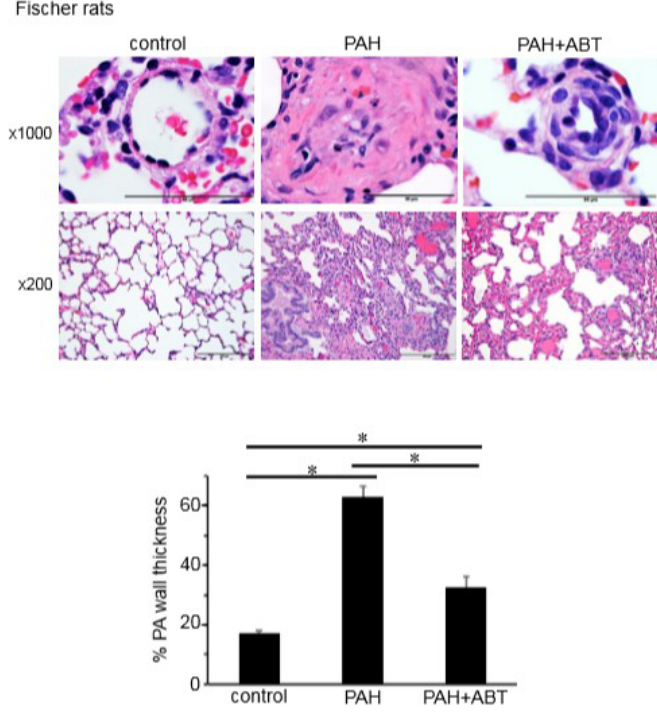
Figure 6. ABT-263 reverses PA remodeling in Fischer rats treated with SU5416/hypoxia. Fischer (CDF) rats were treated with SU5416 and sustained hypoxia (three weeks) and then maintained in normoxia. After pulmonary vascular remodeling was developed, ABT-263 was then injected. The lungs were harvested, immersed in buffered 10% formalin and embedded in paraffin for H&E staining. Representative images at ×1000 and ×200 magnifications are shown. The bar graph represents means ± SEM of % PA wall thickness (n = 5). * denotes that the values were significantly different from each other at p < 0.05.